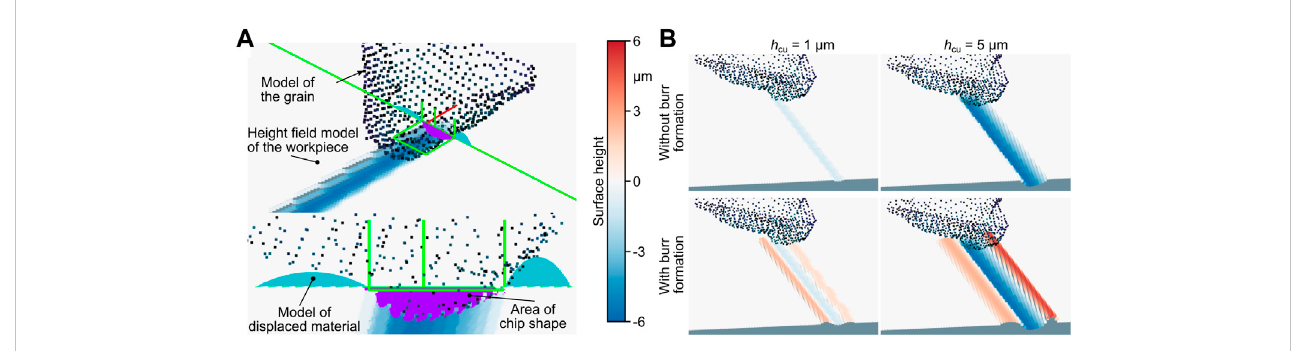
FIGURE 5 (A) Approachformodelingburrformationinthegeometricphysically-basedsimulation. (B) Resultsofsimulatedgrainengagementswithandwithoutthe modeling of burr formation for two different undeformed chip